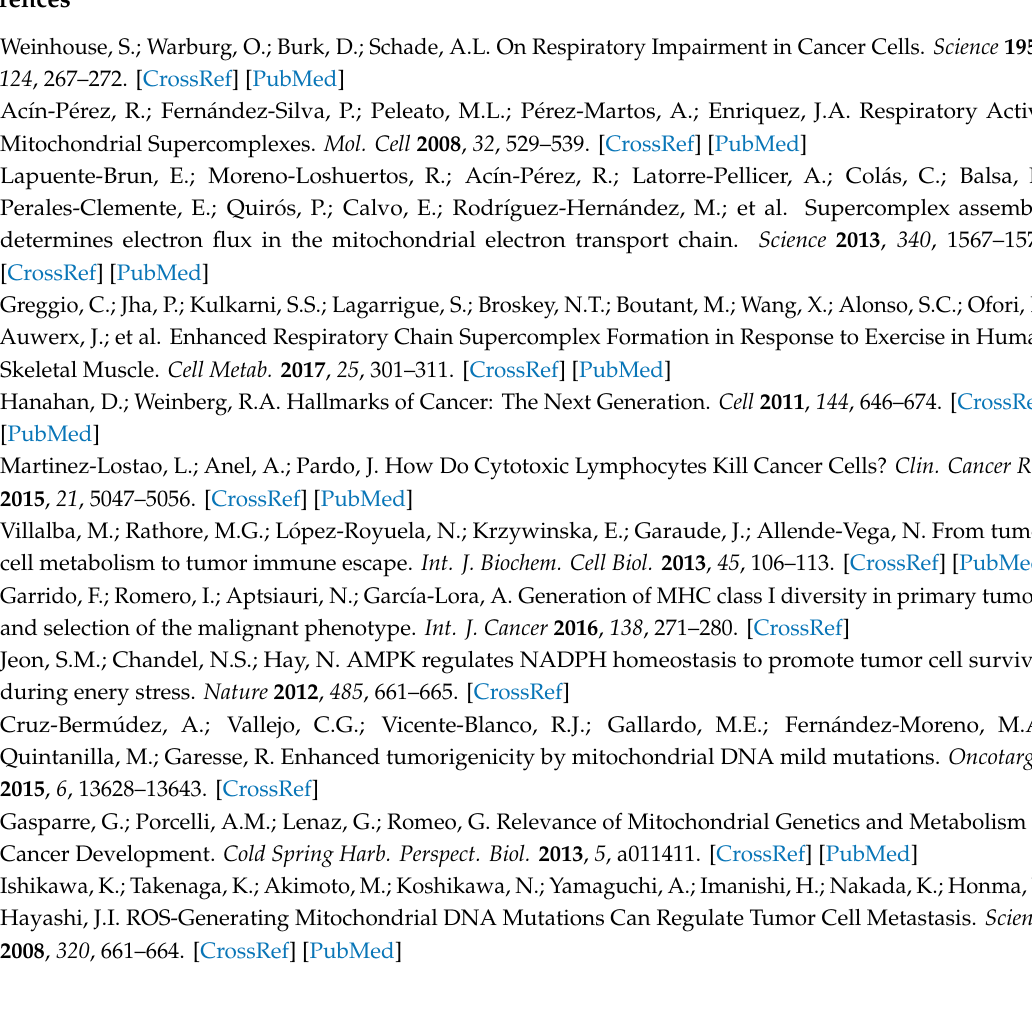
Figure S1: Expression of complex V ( α - β F 1 ATPase) in L929 and L929dt cells, Figure S2: Oxygen consumption of L929 and L929dt cells, Figure S3: Duplication time of L929 and L929dt cells, Figure S4: Alanine repetitions in L929 and L929dt cells, Figure S5: Determination of the amount of mitochondrial superoxide anion in basal conditions in L929, L929dt, L929dt L929 and L929 dt cells, Table S1: PCR primers, Table S2: Sequencing primers, Table S3: RFLP